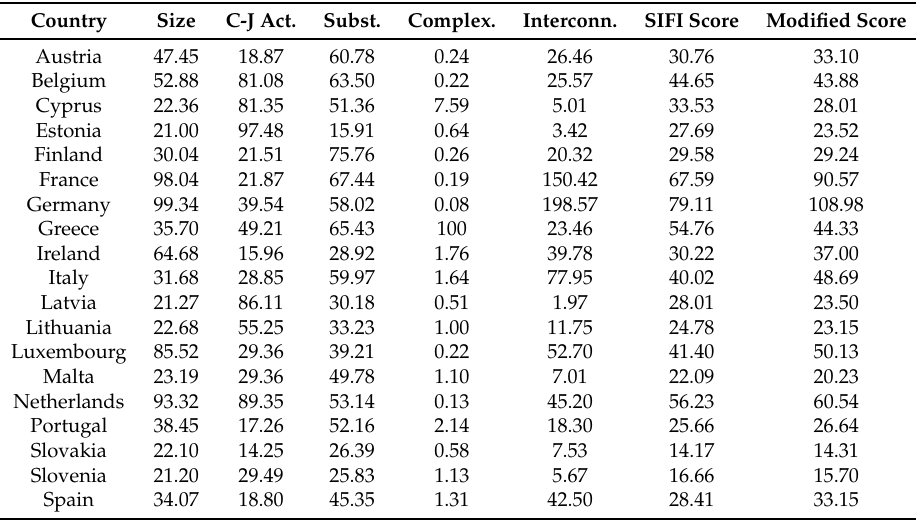
Table 6. Eurozone Adaptive Country Exposure Model (ACEM)